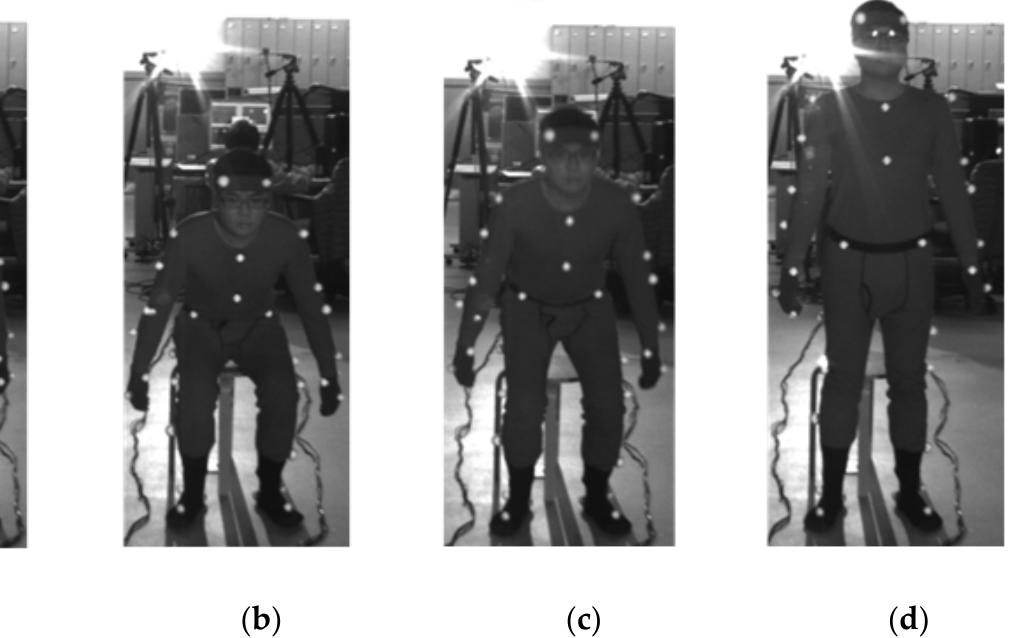
Figure 1. STS measurement experiment. The upper extremity did not touch the body or the outside environment. The plantar was fixed in an arbitrary position that was not interchanged from the beginning to the end of the STS motion. ( a ) The start of the STS motion from the stationary starting posture at the signal, ( b, c ) the STS motion in progress, and ( d ) the end of the STS motion when the ending posture is stationary.